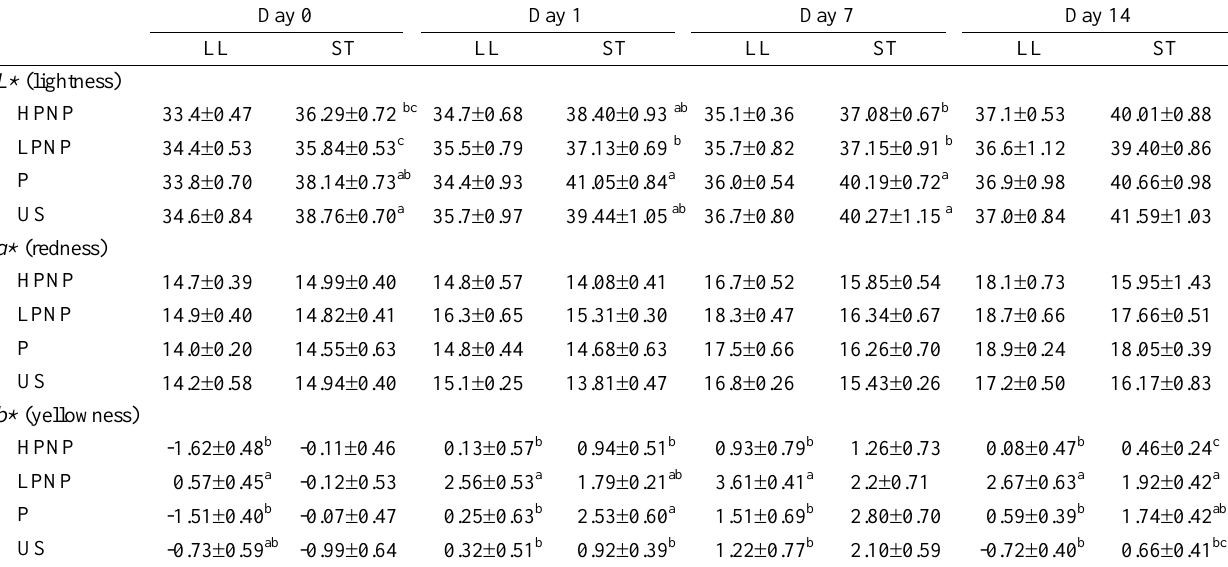
Table 2. Effects of stunning on colour coordinate values ( L *, a *, b *) at different day(s) of ageing (Mean 